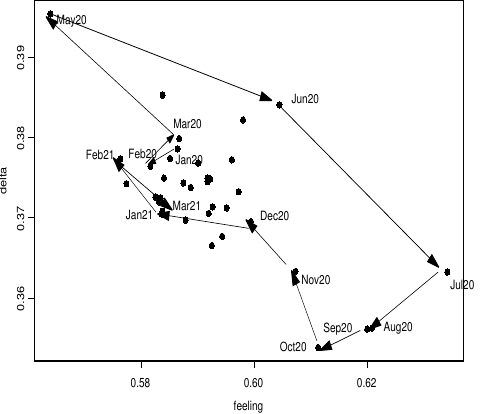
Figure 4. Inflation perceptions: scatter plot of ˆ δ t vs. ( 1 − ˆ ξ t ) .